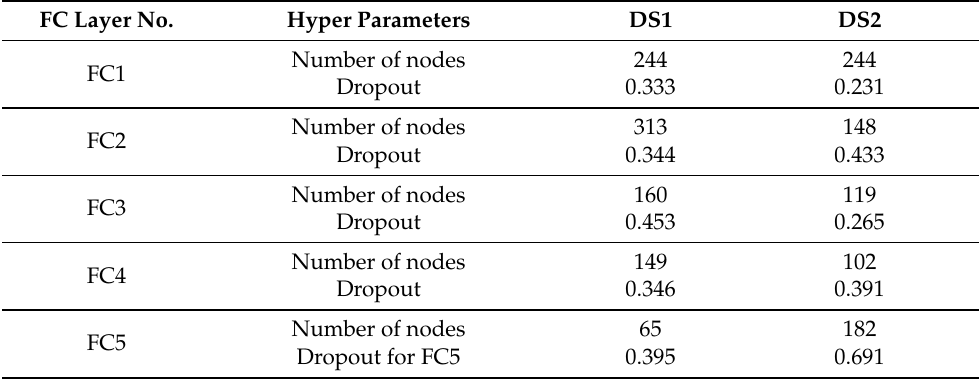
Table 2. Optimal hyper-parameter values of FCDNN for DS1 and DS2. FC Layer